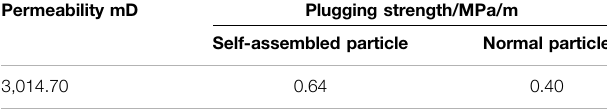
TABLE 5 | Plugging strength of self-assembled particle and normal particle.